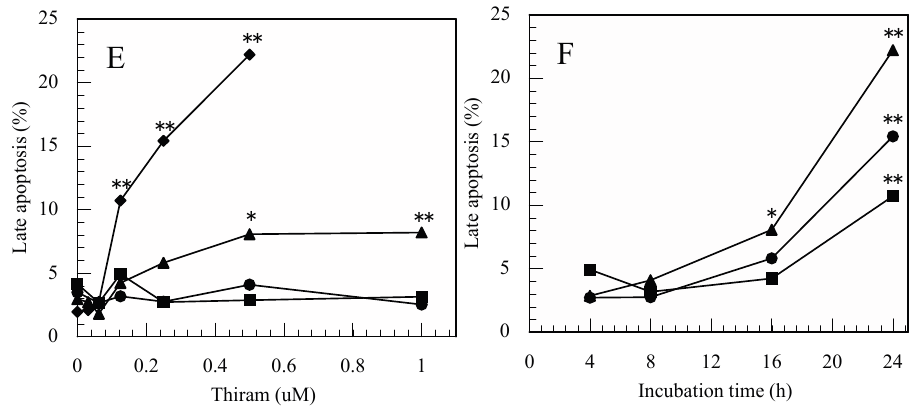
Figure 1. Thiram induced apoptosis in Jurkat T cells. ( A ): dot plot of FITC-annexin V (x axis)/PI (y axis) in control cells, ( B ): dot plot of FITC-annexin V/PI in